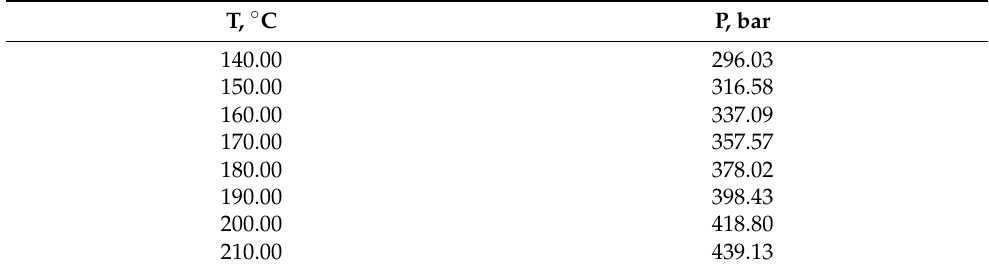
Table 1. Pressure values corresponding to the temperatures lying on the 1.1 ρ cr. (CO 2 ) isochore. T, ◦ C P, bar